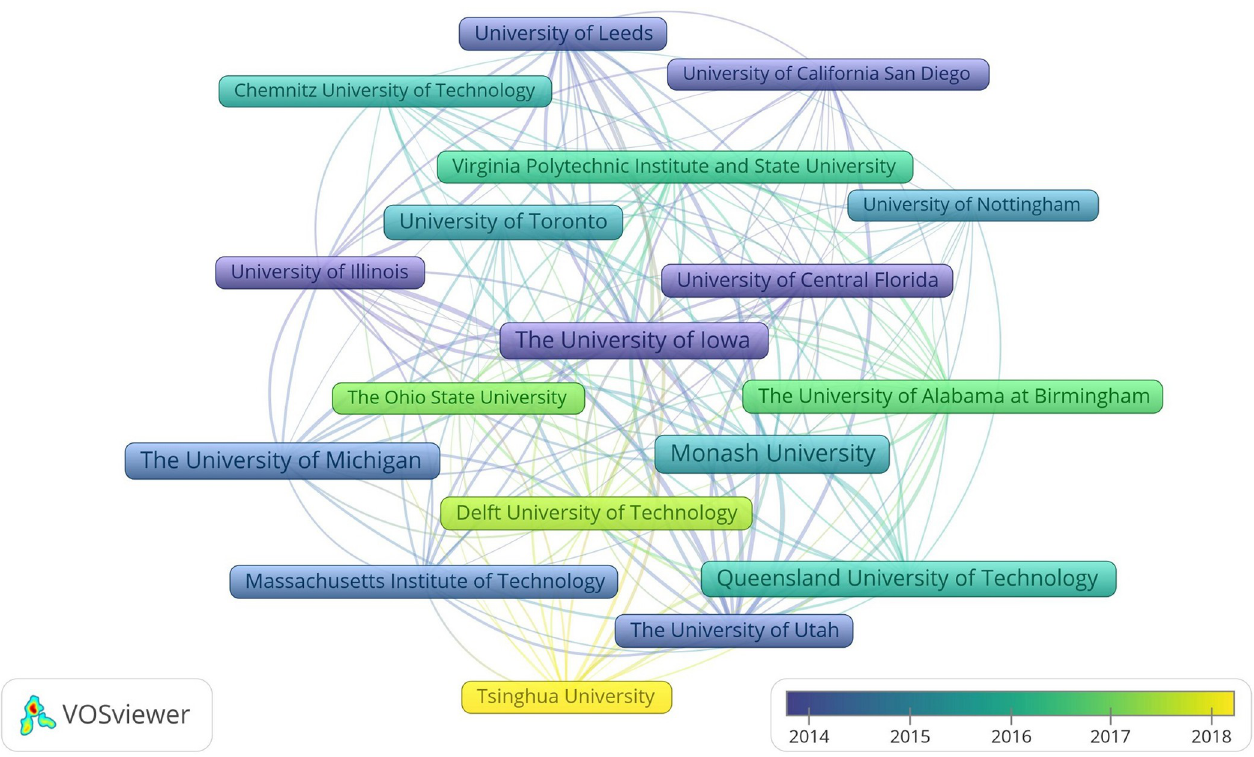
Fig 5. Distribution of documents among